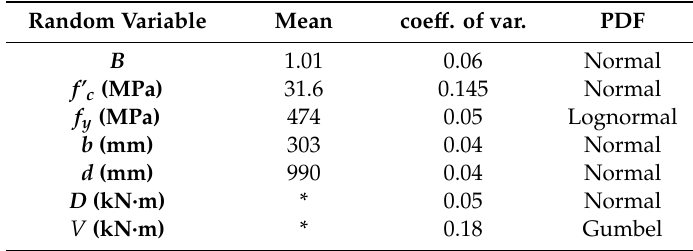
Table 3. Random variables for the limit state functions (LSF) of the reinforced concrete beam (RCB) considered. Random Variable Mean coe ff . of var.